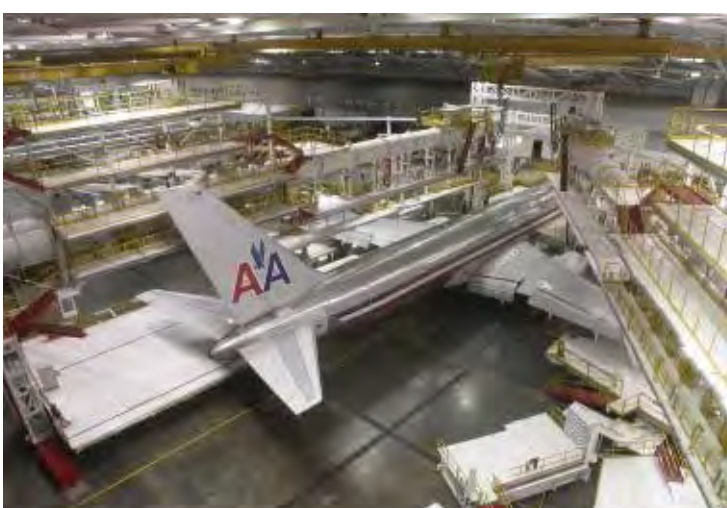
Figure 3. Sharifi-ha House